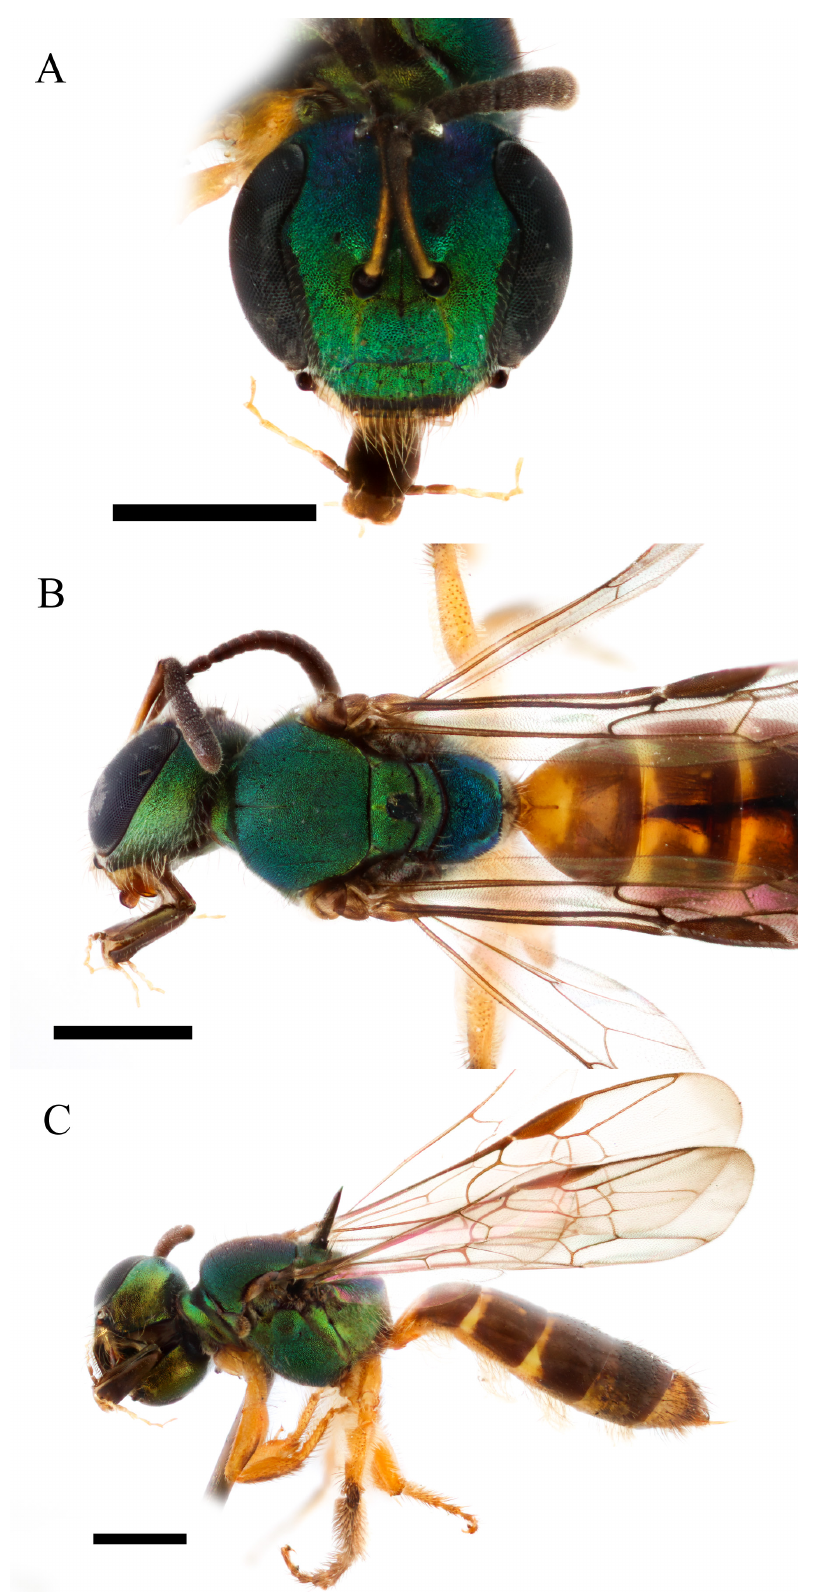
Fig. 17. Habralictus antillarus sp. nov. Paratype, ♀. A . Face. B . Lateral habitus. C . Dorsum of mesosoma. Scale bars = 1